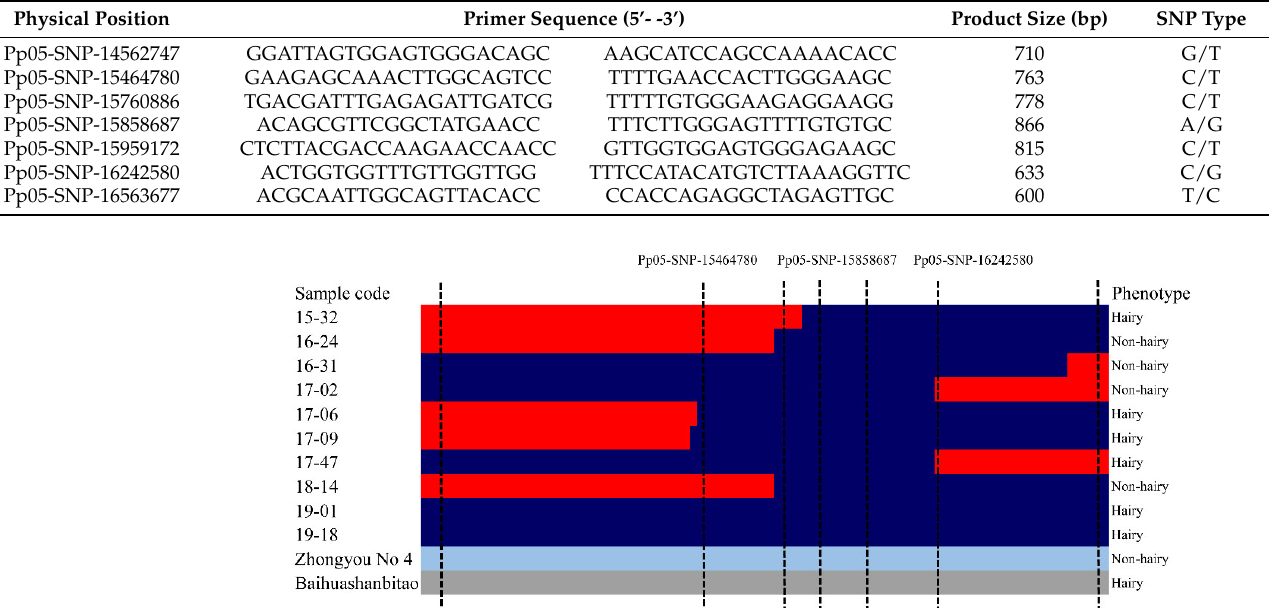
Table 1. Primers used in fine mapping for peach skin hairiness.